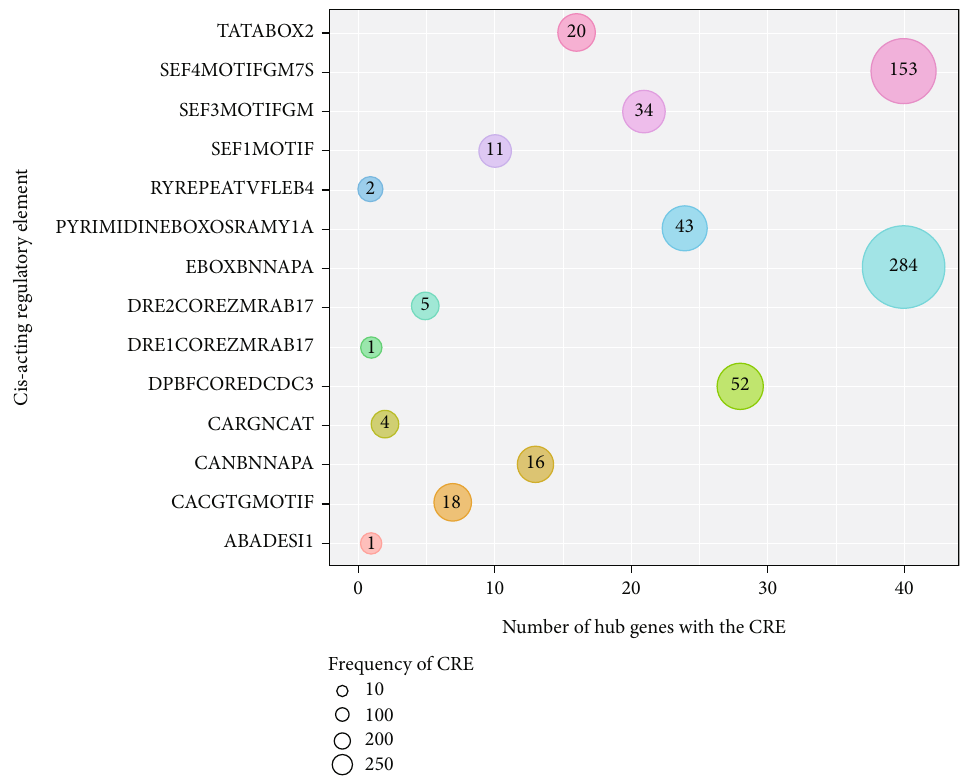
Figure 8: Venn diagram indicating the intersection of hub genes and DEGs ( j log 2465 [24] and GSE48915 [37].